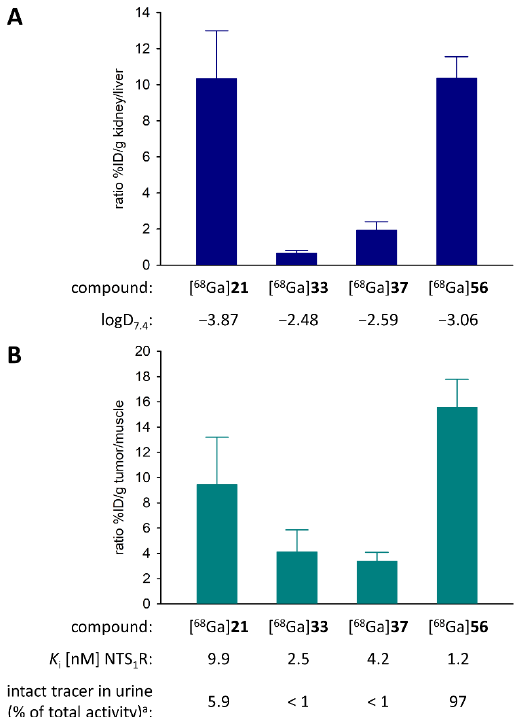
Figure 4. Ratio of the %ID/g values of ( A ) kidney and liver and of ( B ) tumor and muscle, obtained from biodistribution experiments with [ 68 Ga] 21 , [ 68 Ga] 33 , [ 68 Ga] 37 and [ 68 Ga] 56 in HT-29 tumor- bearing mice. Given are mean values ± SD from three ([ 68 Ga] 33 , [ 68 Ga] 37 ) or four ([ 68 Ga] 21 , [ 68 Ga] 56 ) independent experiments. a Given is the relative area (as percentage of the total peak area) of the peak corresponding to the intact PET ligand in the radiochromatogram of the HPLC analysis of the urine sample obtained 45 min after injection of the tracer.